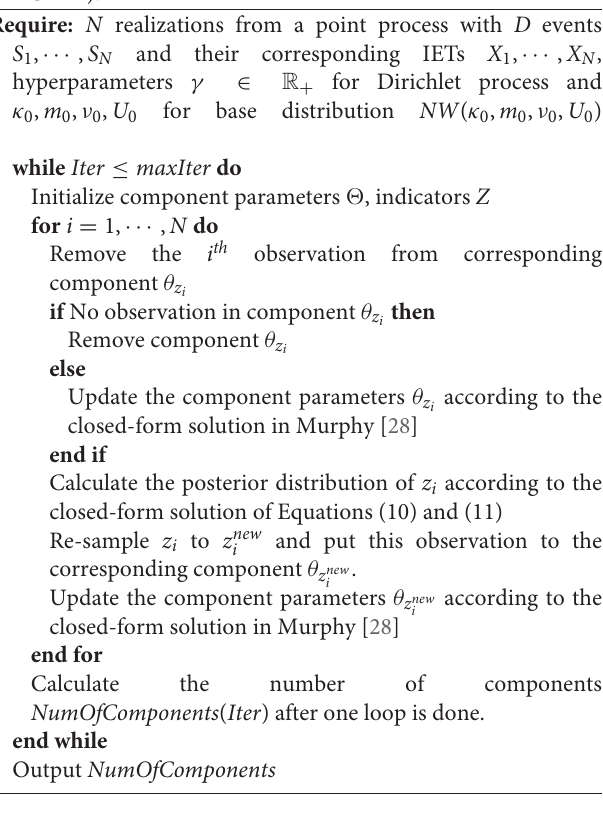
Algorithm 4 Dirichlet Process Gaussian Mixture Model